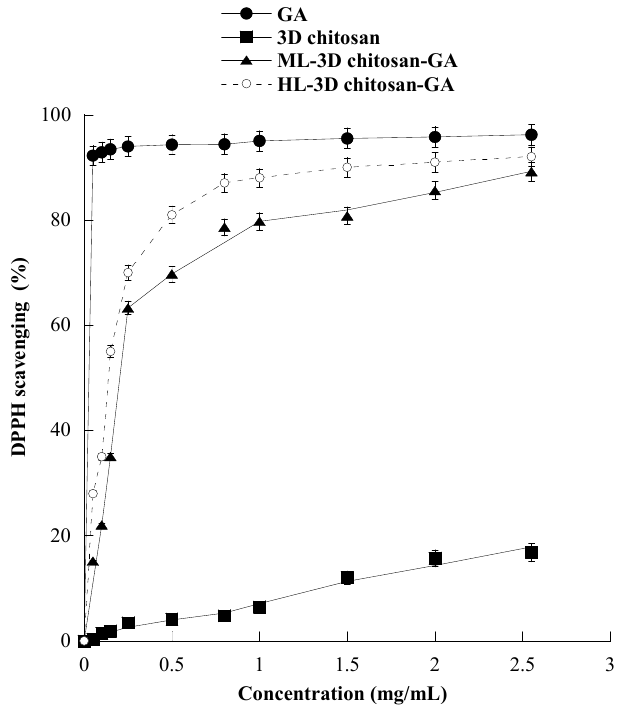
Figure 6. Scavenging activity against the DPPH radical of 3D chitosan, GA, ML-3D chitosan-GA, and HL-3D chitosan-GA at pH 3.5. The GA equivalent in ML- and HL-3D chitosan complex was 168.42 and 342.79 g kg − 1 , respectively. 3D-chitosan-GA samples were dried for seven days before measurements.